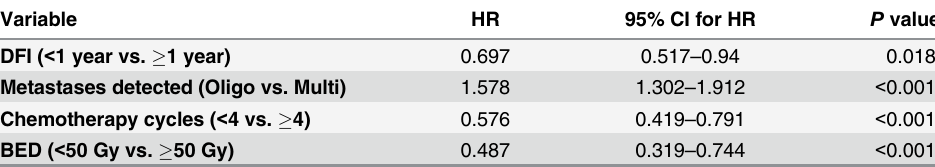
Table 3. Multivariate analysis of clinical variables for metastatic survival